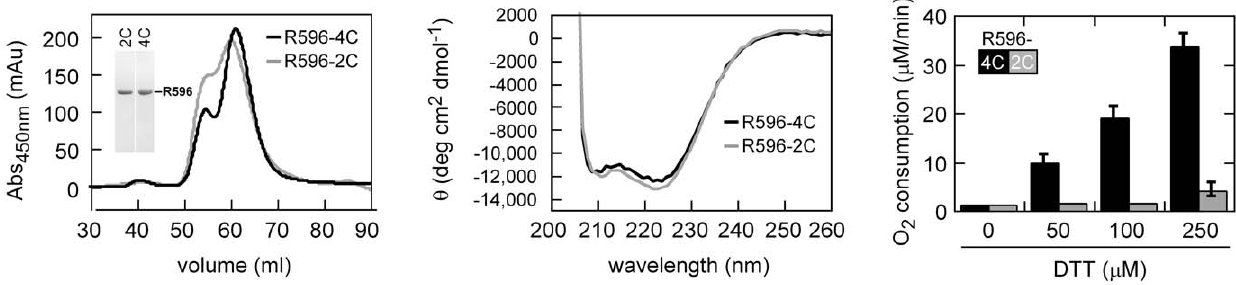
Figure 6. Contribution of C146/C156 to catalysis. (A) Gel filtration and gel electrophoretic (inset) profiles and (B) circular dichroism spectra of R596 variants containing (R596-4C) and lacking (R596-2C) the C146/C156 cysteine pair. These experiments demonstrate that both variants are intact and have similar secondary and quaternary structures. The R596 variants show two overlapping peaks by gel filtration. This phenomenon is not due to protein degradation, and both peaks of R596-4C gave similar catalytic activity (not shown). (C) Initial rates of oxygen consumption by R596 variants (1 m M) were monitored after addition of DTT at the indicated concentrations. The R596 variant containing the apparent shuttle disulfide, R596-4C, is considerably more active (black bars) than the variant, R596-2C, in which the C146 and C156 cysteines were replaced by alanines (gray bars). The R596-4C values are the average and standard deviation of at least four measurements from two independent preparations of enzyme.